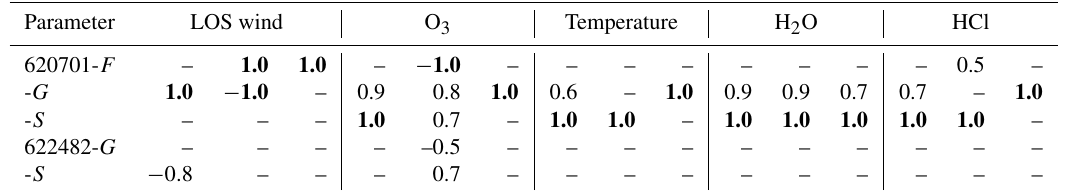
Table A3. Same as Table A1 but for the H 2 O line parameters Parameter